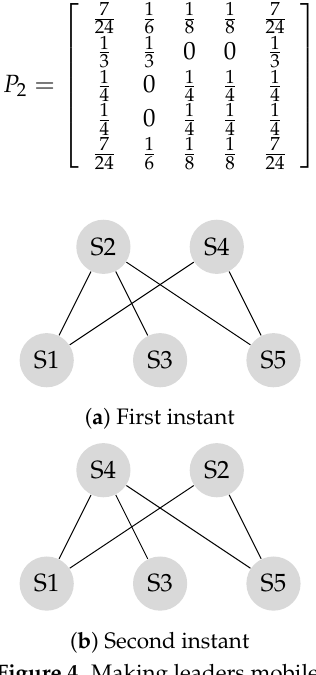
Figure 4. Making leaders mobile.